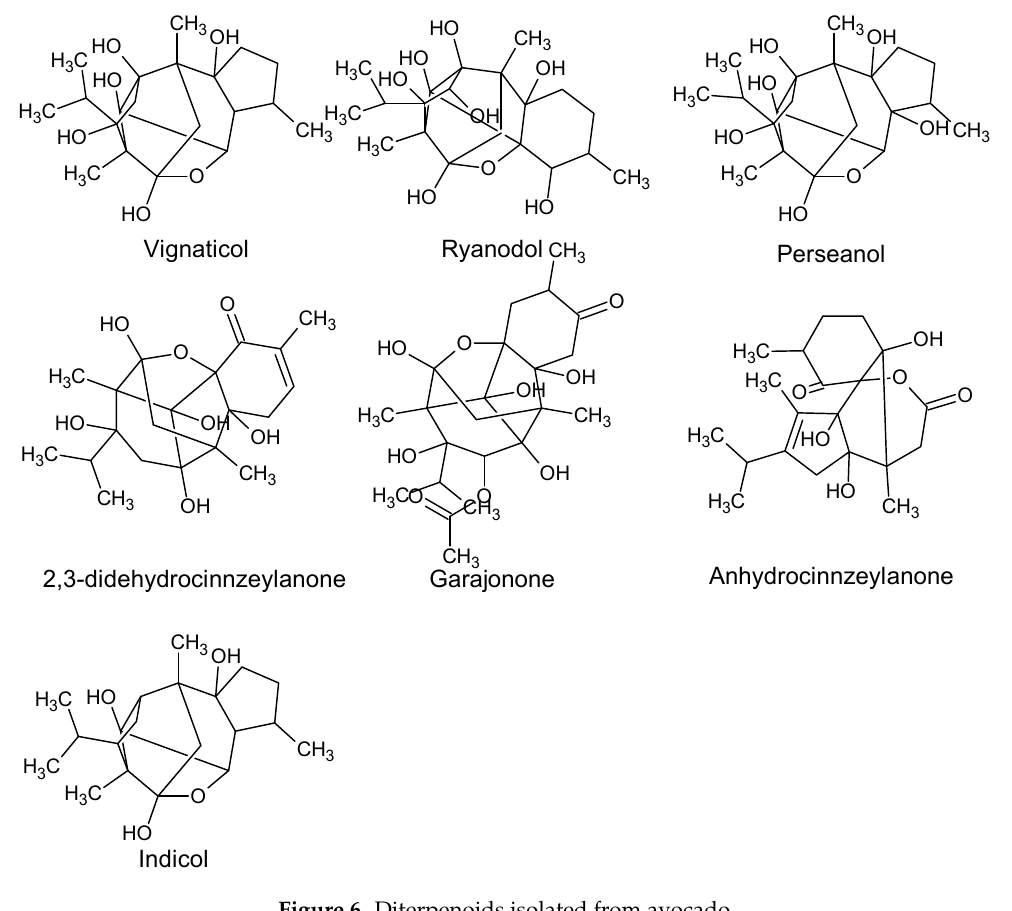
Figure 6. Diterpenoids isolated from avocado.